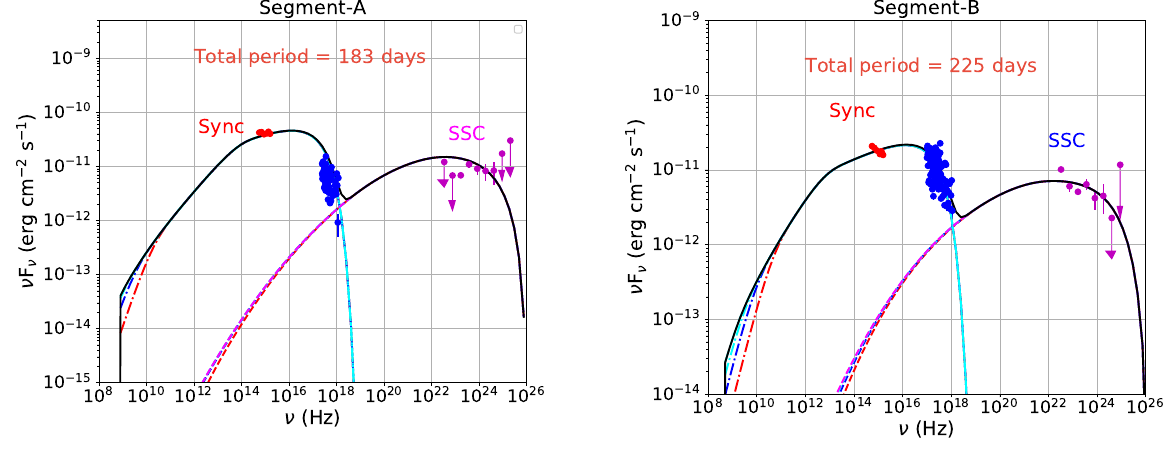
Figure 2. Models for the broadband emission from radio to gamma rays of OJ 287, for two datasets observed during the years 2017–2020. The dotted-dashed and dashed line represent synchrotron and SSC emission computed with GAMERA; the different colors represent different times of the electrons distribution evolution. Optical/UV, X-ray, and gamma-ray flux measurements are displayed with red, blue, and magenta markers, respectively. Figure from [41], reproduced with permission of Astronomy and